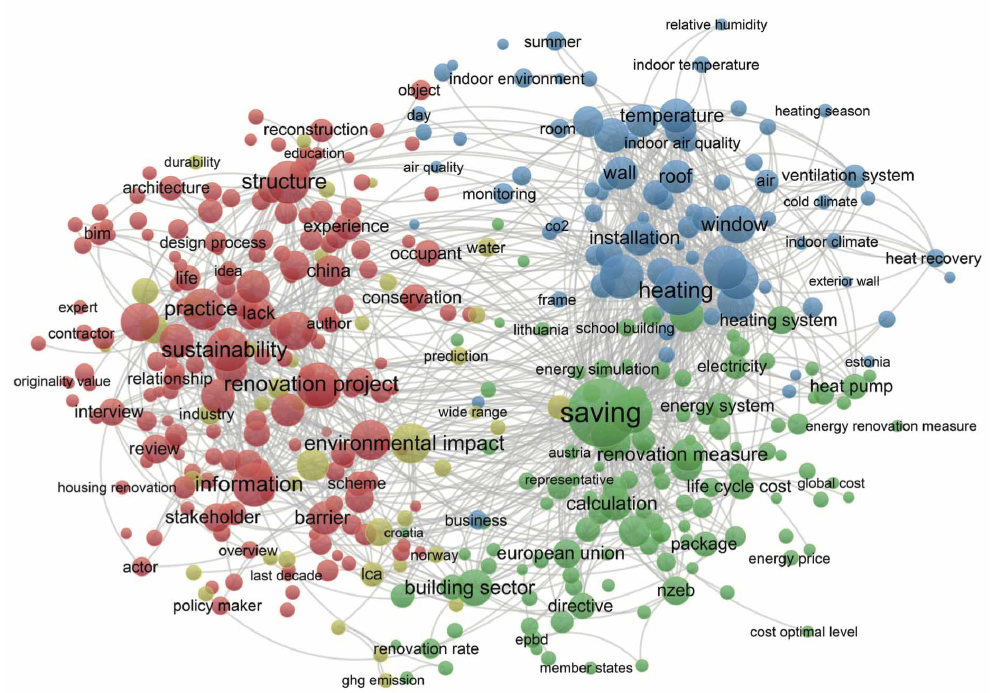
Figure 8. Co-occurrence of professional